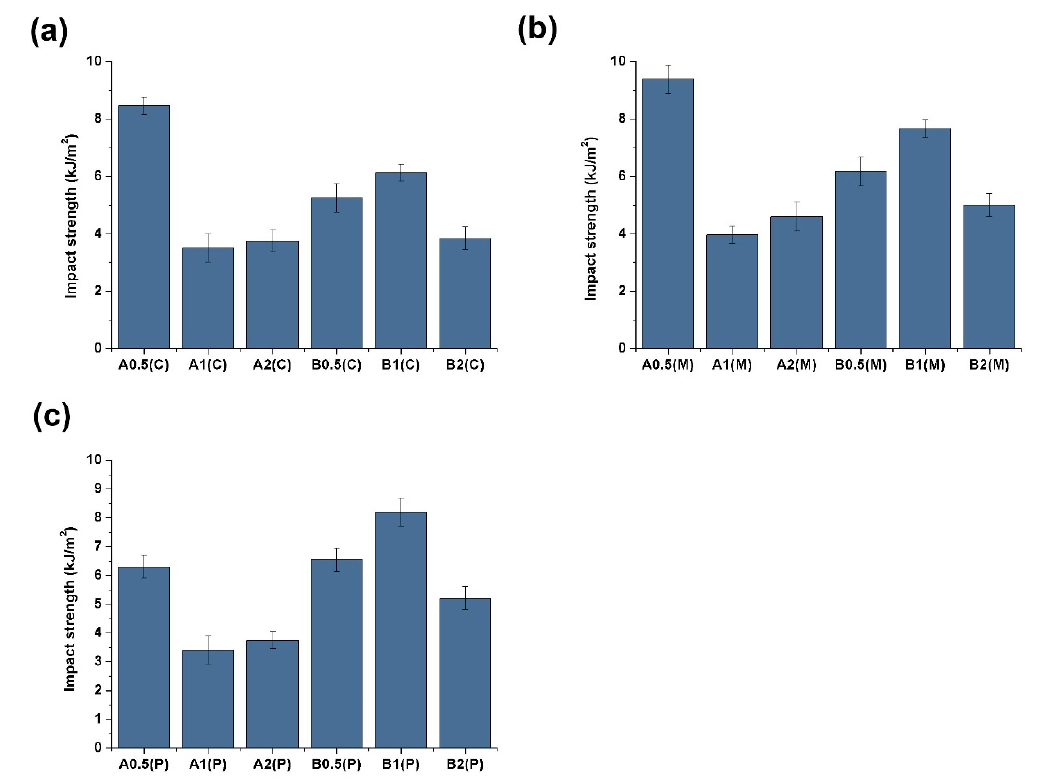
Polymers 2019 , 11 , x FOR PEER REVIEW 9 of 17 Figure 5. Impact strength of di ff erent samples molded by ( a ) CIM, ( b ) MFVIM, and ( c ) PVIM. Figure 5. Impact strength of different samples molded by ( a ) CIM, ( b ) MFVIM, and ( c ) PVIM.